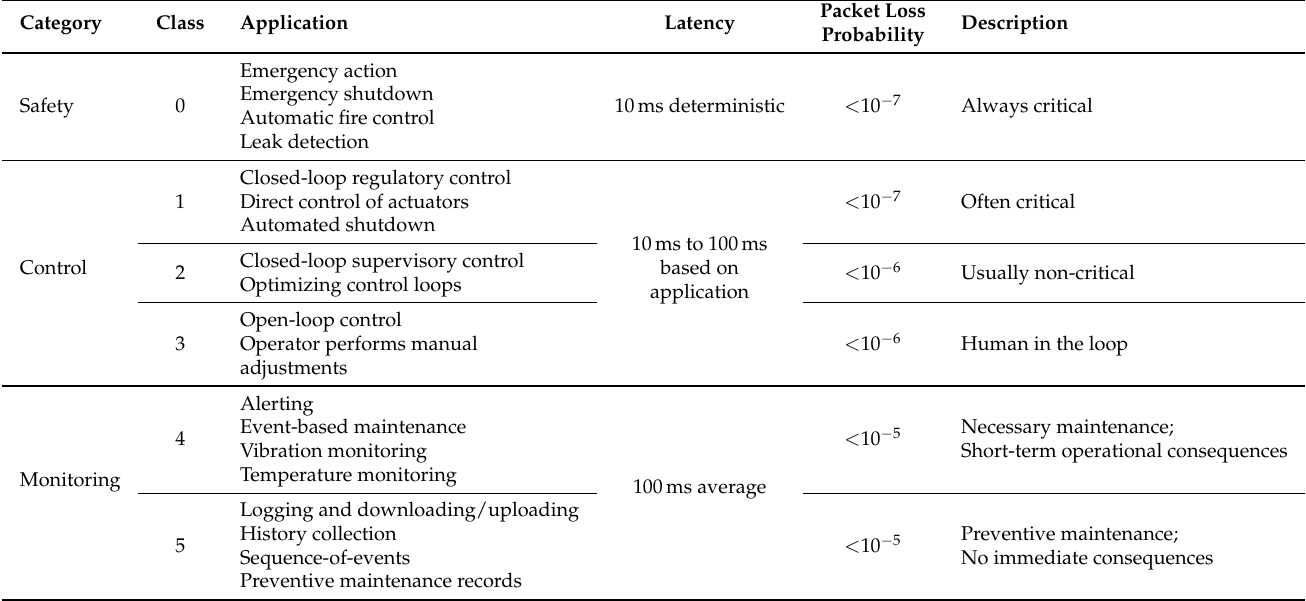
Table 1. Classes of industrial process automation